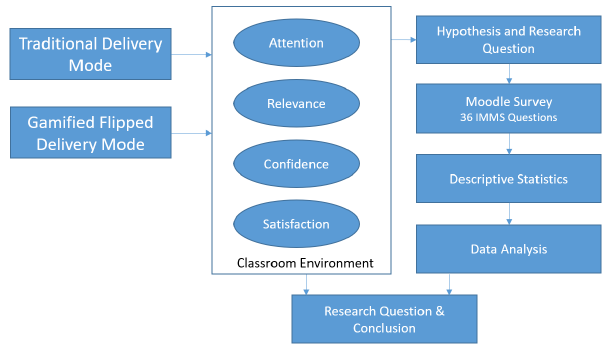
Figure 3. Research design of the